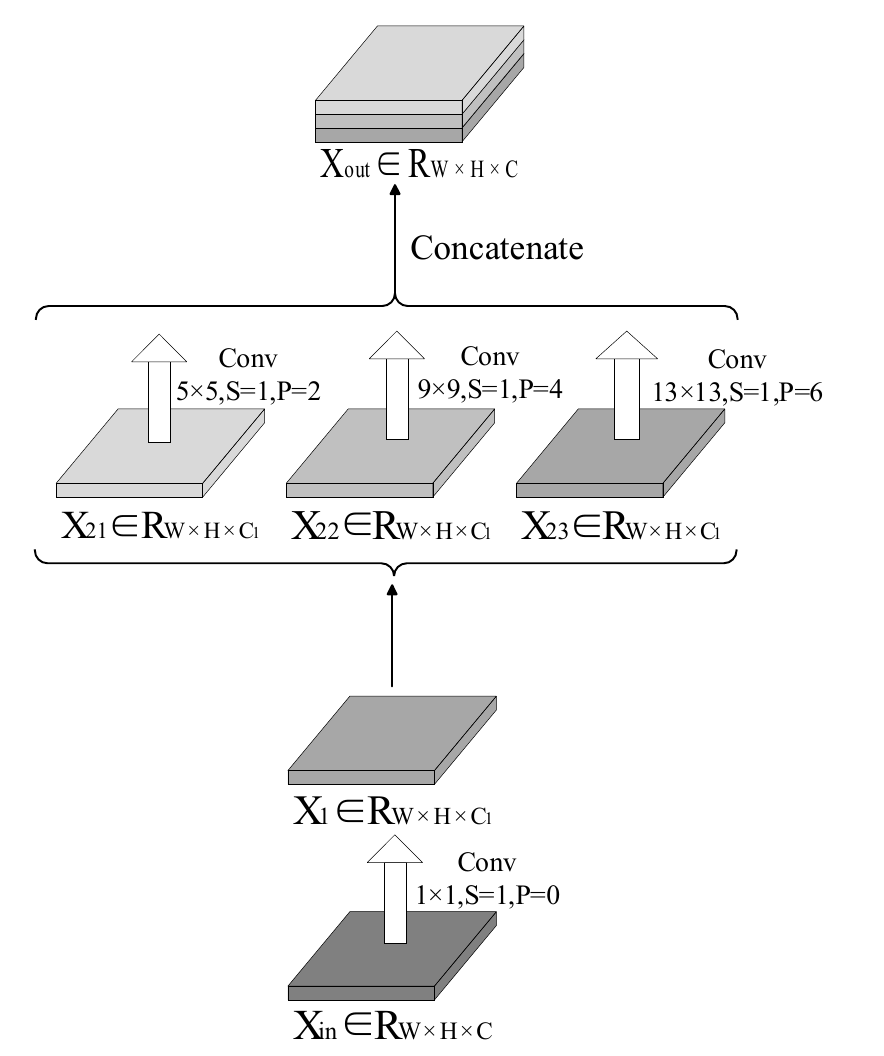
Figure 6. Spatial pyramid convolutions (SPC) structure.